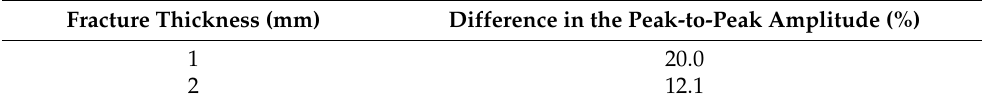
Table 2. Variations in the peak-to-peak amplitudes of the air-filled and resin-filled layers between marble